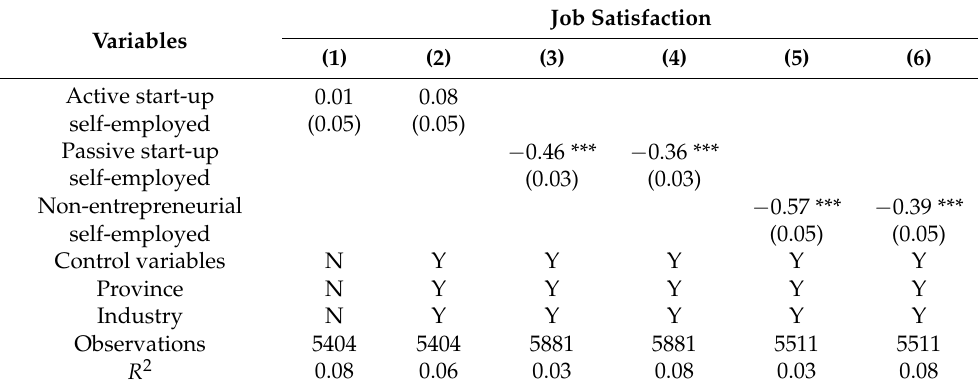
Table 4. OLS regression results of job satisfaction of different types of self-employed workers.